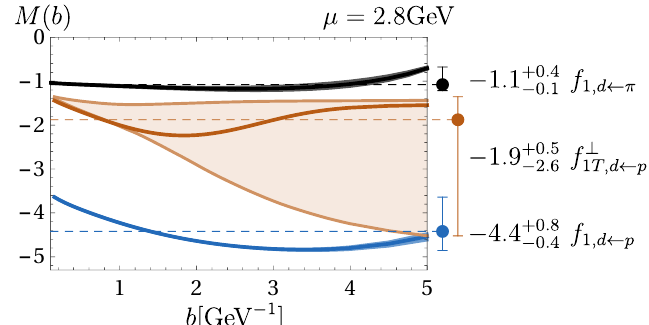
(2.22) computed using fits for the d-quark unpolarized TMDs Figure 3 . The function M [Γ] f ← h in the proton (blue) and in the pion (black), and from the d-quark Sivers function (brown) in refs. [12, 35, 36], with uncertainty bands. The numbers to the right show the mean and the error for each case, where the error is given by the maximal deviation. Note that for the unpolarized TMD f there is more precise experimental data available than for the Sivers function f 1